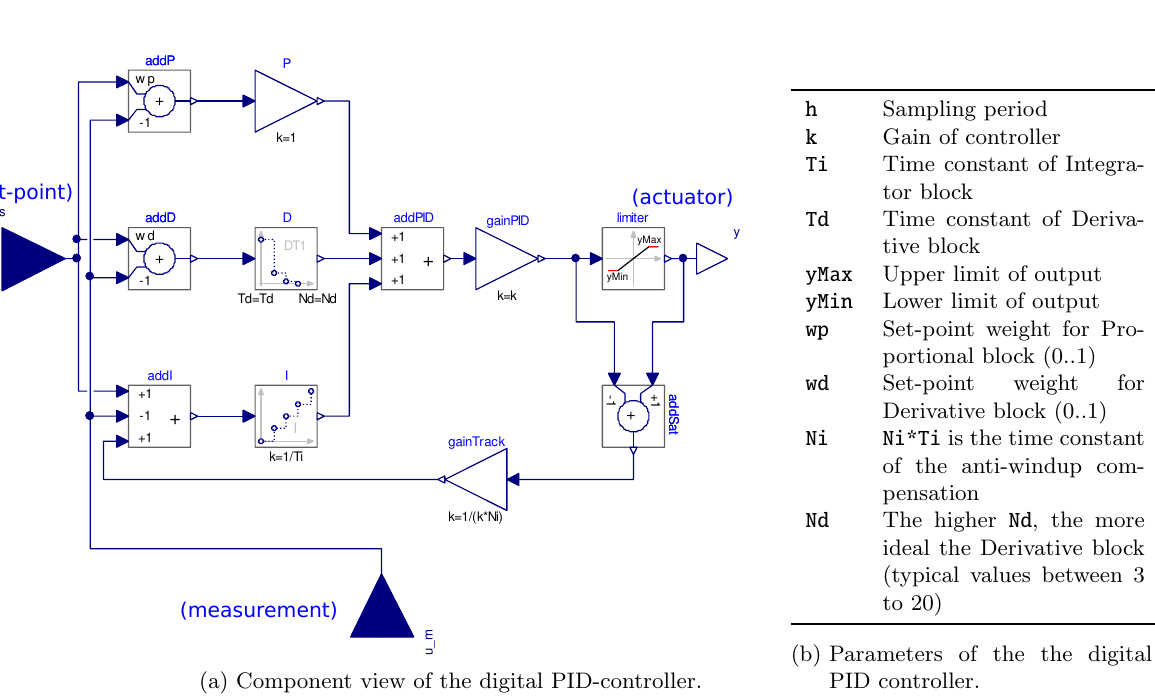
SIL simulation using the generated code Original controller model